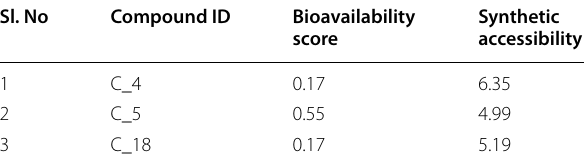
Table 7 Bioavailability score and synthetic accessibility of the